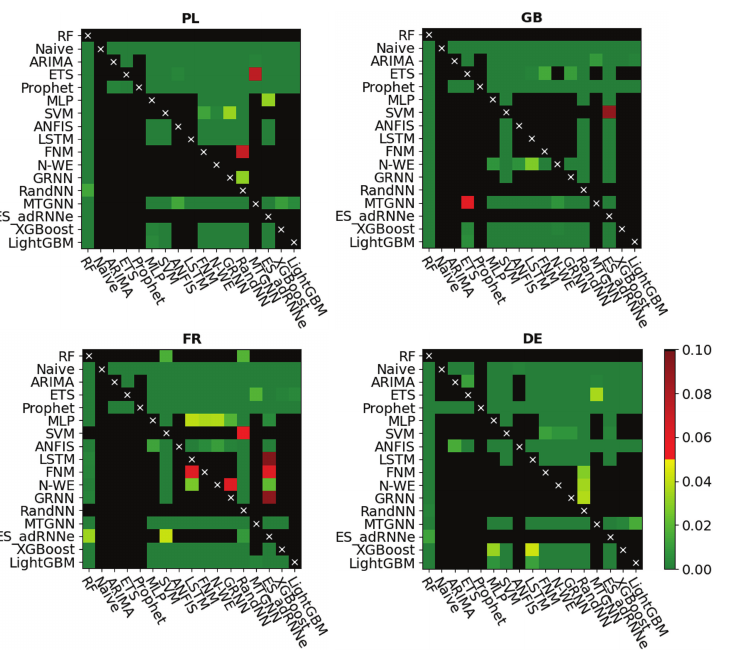
Figure 9. Results of the Giacomini-White test for the proposed and baseline models (black color is for p -values larger than